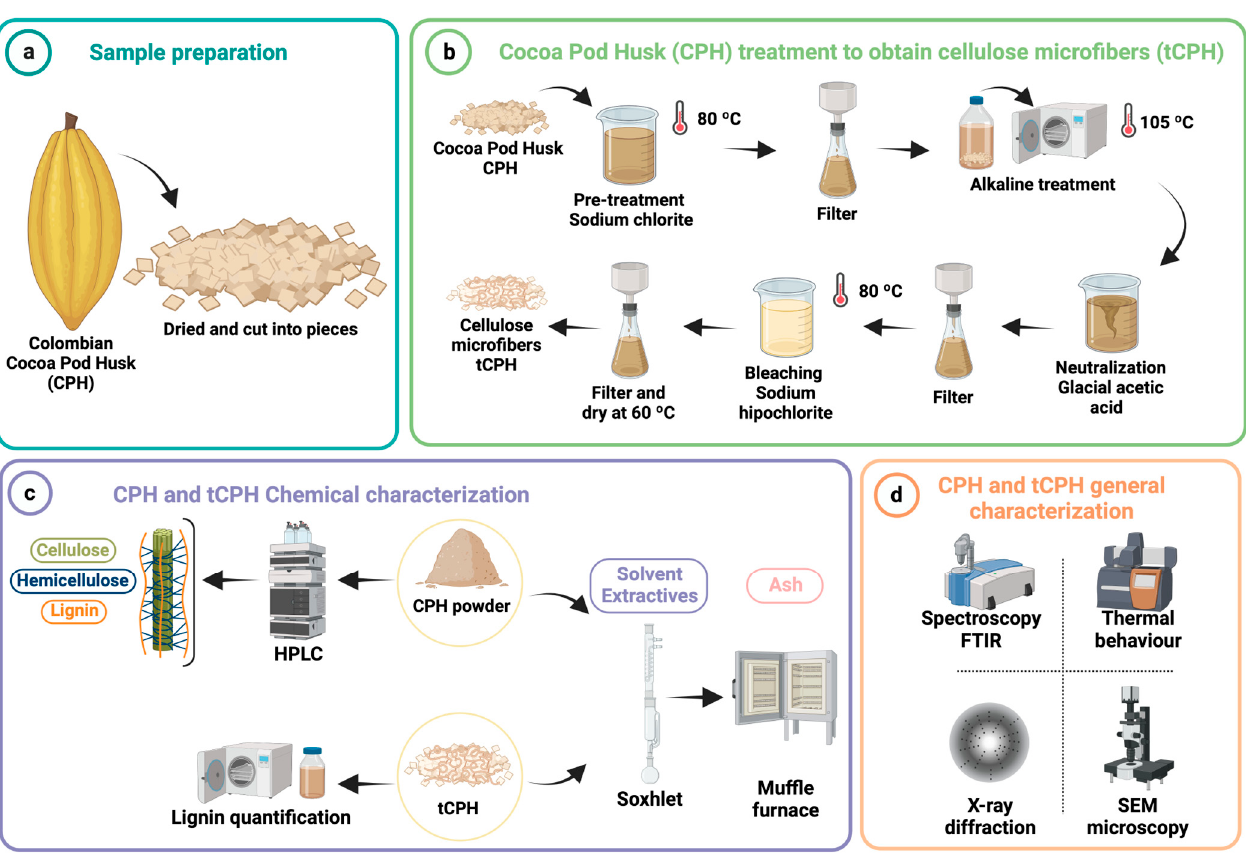
Figure 1. Graphical summary of the procedure to obtain tCPH from CPH and its characterization. ( a ) Sample preparation process. ( b ) Fiber pretreatment, alkaline hydrolysis with high pressure, and bleaching method to obtain tCPH. ( c ) Chemical and physical characterization of CPH and tCPH. ( d ) General characterization of CPH and tCPH. Created with